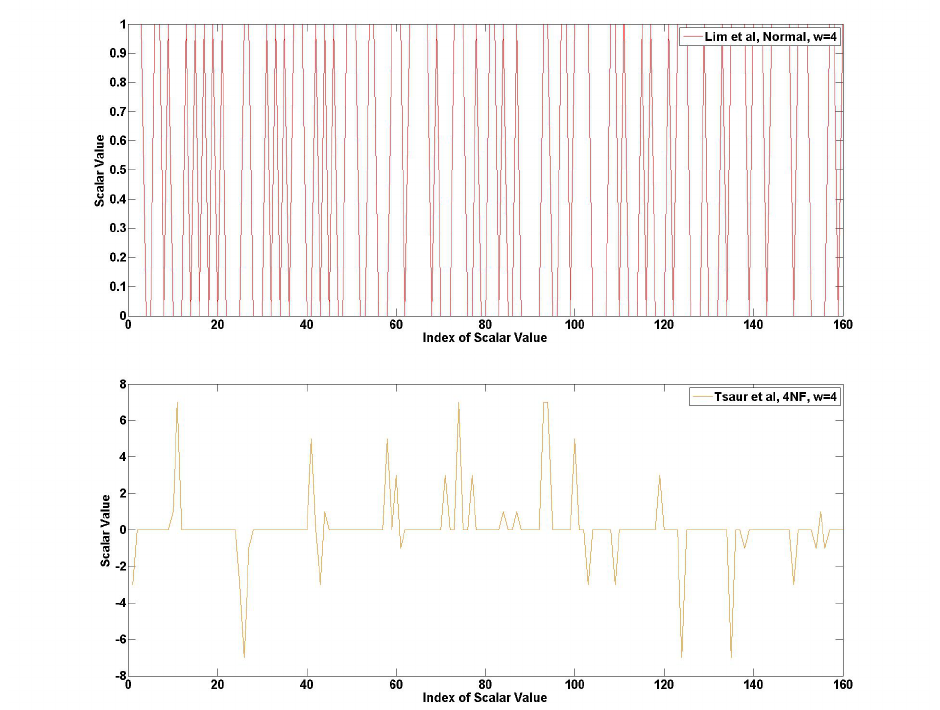
Figure 16. Frequency of scalar value represented in